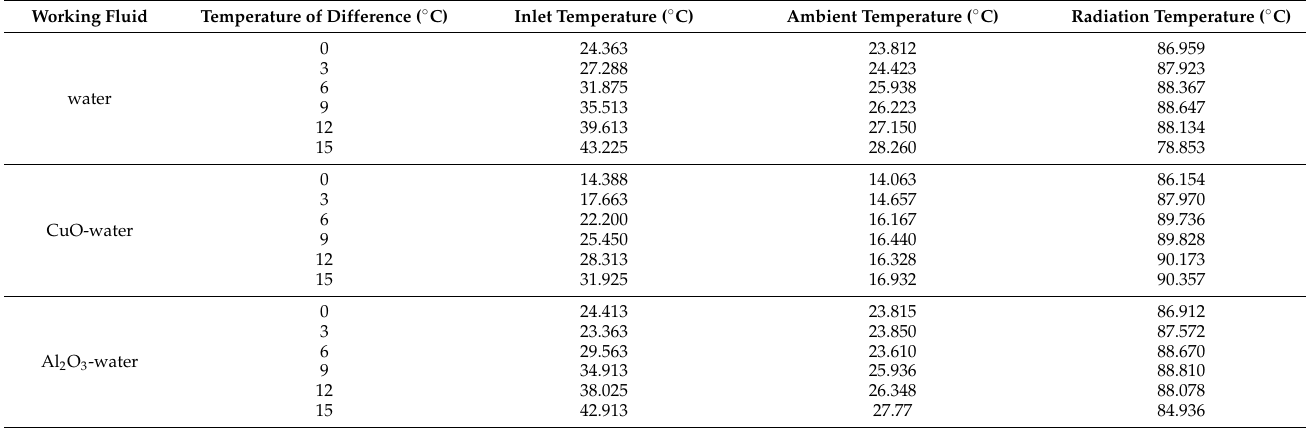
Table 4. Input values used for